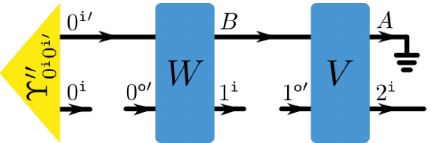
FIG. 22. Process tensor corresponding to Fig. 21. Rearranging the wires of the circuit of Fig. 21 and removing the maximally entangled states (i.e., undoing the CJI), yields the representa- tion of a process tensor we already encountered in the previous section. As above, note that H o this is indeed the correct dilation of ϒ